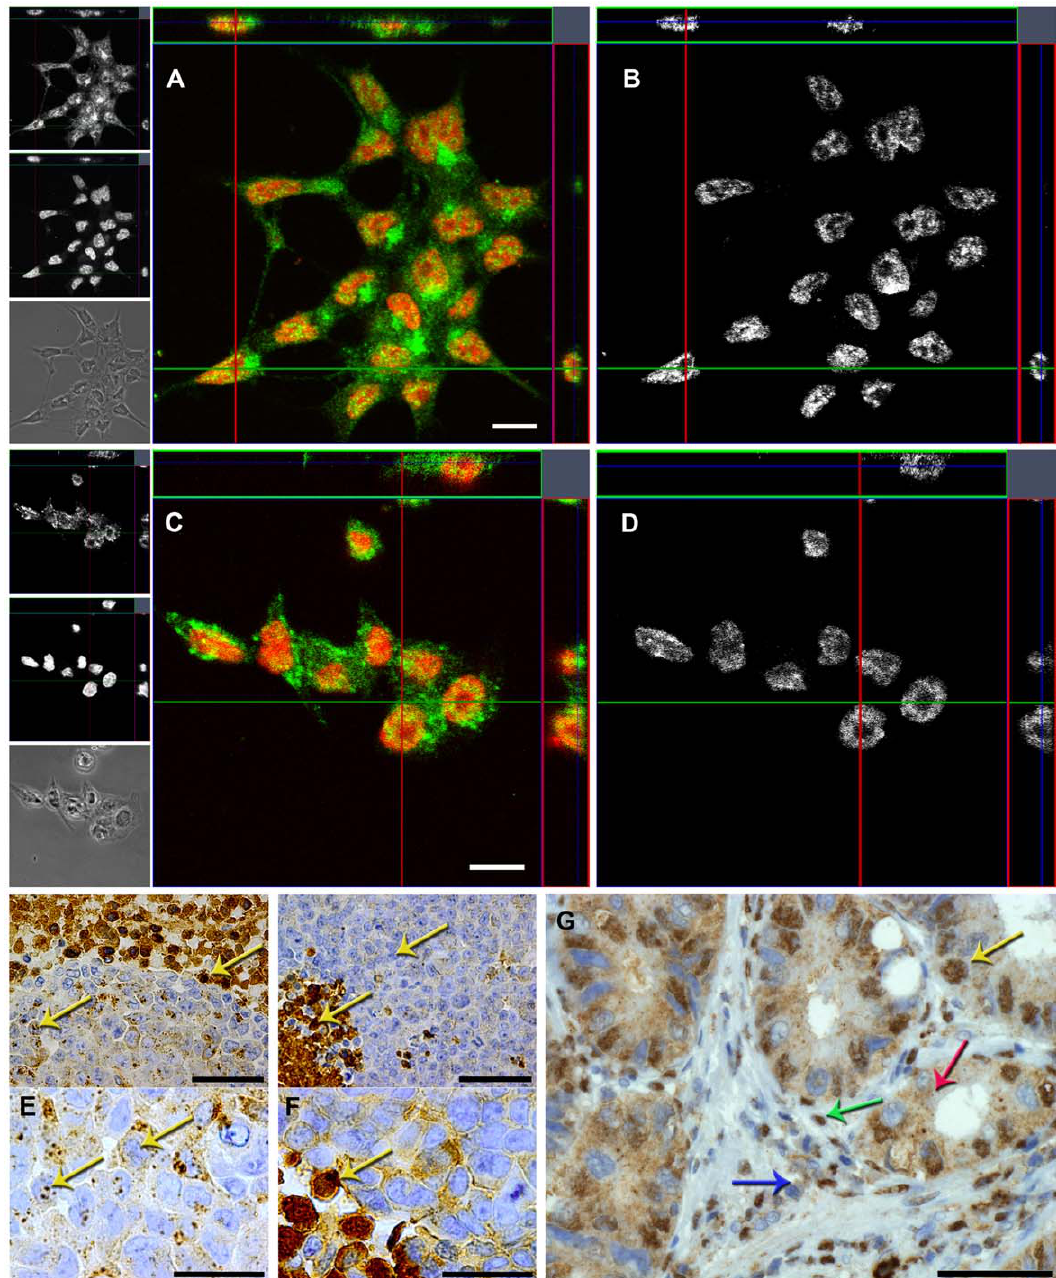
Figure 4. Subcellular localization of legumain in HCT116 and SW620 cells, subcutaneous xenografts, and human CRC tumor tissue. (A to D) Immunofluorescence staining of legumain (green and top left panels) and nuclei (red and middle left panels) in HCT116 (A) and SW620 (C) cells cultured on glass slides and visualized as orthogonal slices of z-stacks by confocal laser scanning microscopy. By using image arithmetics with the binarized capture of corresponding DRAQ5 TM -positive nuclei as a mask, nuclear legumain representative signals were extracted from all optical sections and visualized in grayscale as orthogonal slices for HCT116 (B) and SW620 (D). Scale bars represent 10 m m. Specificity of immunofluorescence signals was verified by incubation with secondary antibodies only, yielding no signal (Fig. S3A and S3B). (E and F) When grown as subcutaneous xenografts in mice, immunohistochemical staining of legumain in HCT116 (E) cells demonstrated a much more granulated staining pattern than in SW620 (F) cells. However, both cell lines exhibited areas of strong legumain expression and also in the nuclei (yellow arrows). Scale bars represent 50 (top panels) and 25 (bottom panels) m m. H/E stain (Fig. S3C and S3D). Goat-IgG isotype control showed low staining (Fig. S3E and S3F). (G) Immunohistochemical staining of legumain in paraffin-embedded section from a representative CRC tumor biopsy showing nuclear staining of legumain in some, but not all, epithelial cells (i.e. carcinoma cells; yellow arrow) and stromal cells (green arrow). Epithelial cells also exhibited marked granulated staining in the cytoplasm (red arrow), whereas stromal cells showed much weaker staining outside the nucleus (blue arrow). Scale bar represent 50 m m. Goat-IgG isotype control showed no staining (Fig. S3G).